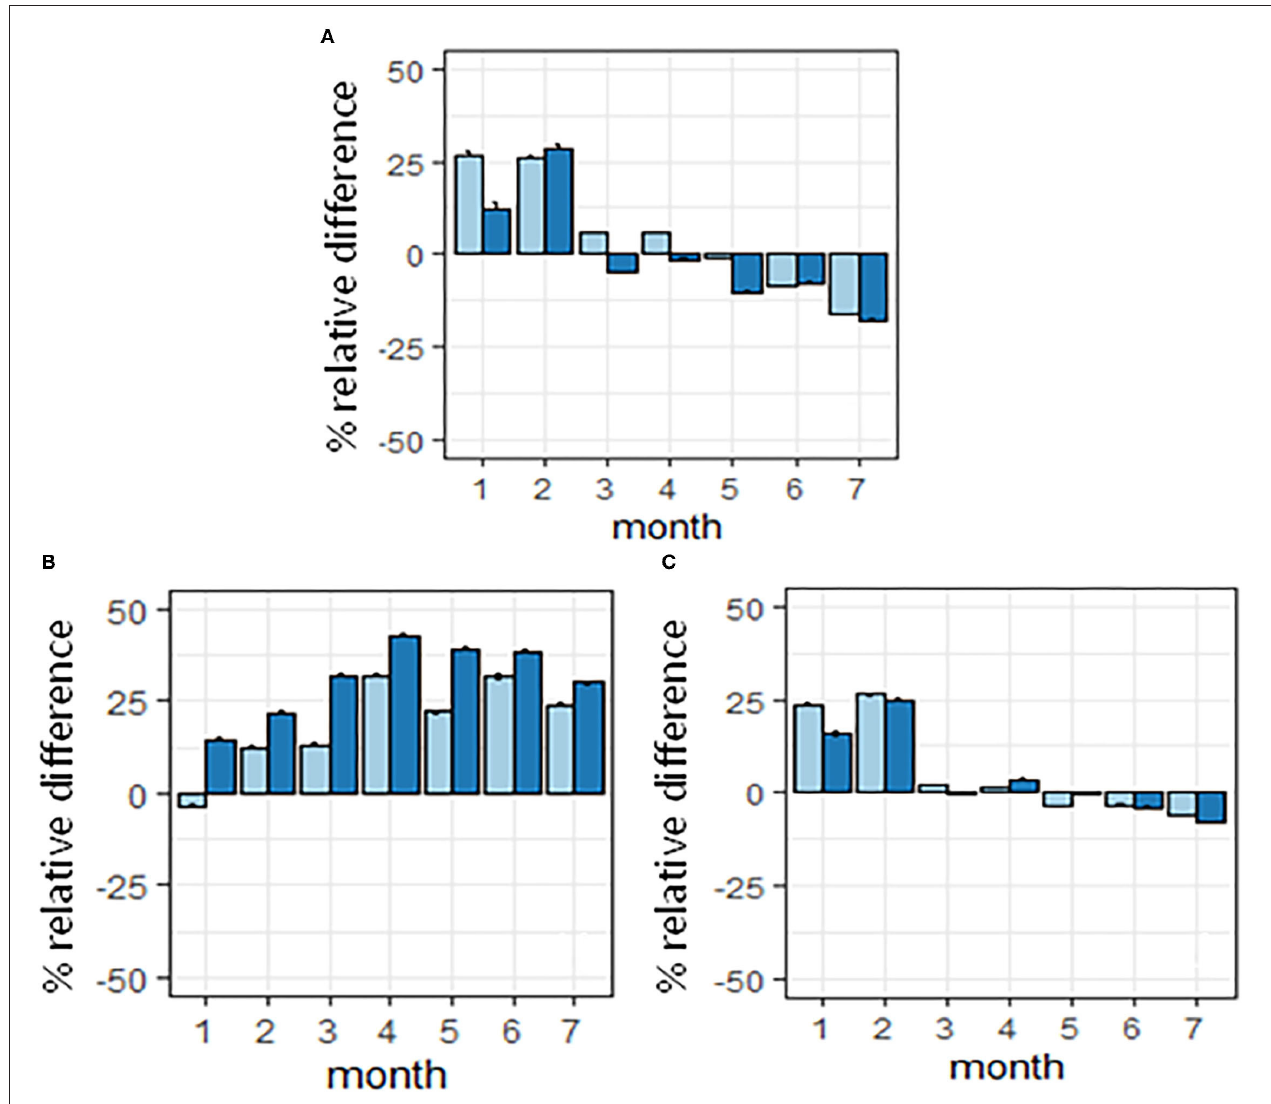
FIGURE 5 | (A) The model fitted exclusively for the Barrio del Pilar air quality station (AQS) data; (B) the global model without location features applied to the Barrio del Pilar AQS data; (C) the global model with dummy variables for the location features for the Barrio del Pilar AQS data. The results are in percentage relative differences for the year 2020 with respect to the AQS